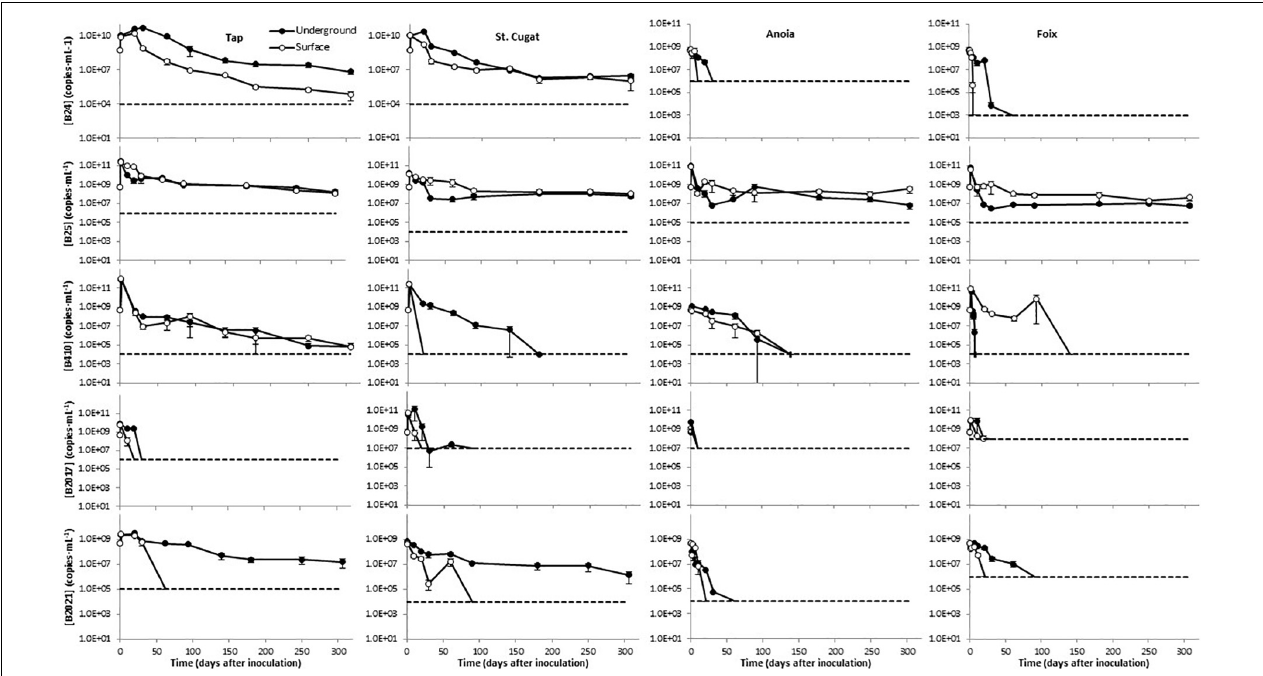
FIGURE 2 | Persistence of five microbial biocontrol bacterial strains in waters of different natures, stored under conditions simulating surface and groundwater. Dashed lines represent the limit of detection; data points below detection limits are omitted. Negative controls (untreated water) yielded concentrations below detection limit in all cases (not